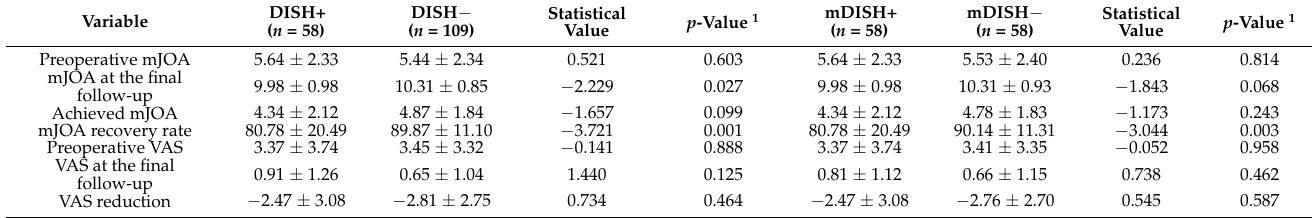
Table 5. Surgery outcomes of patients between the DISH+ and DISH − groups before and after propensity